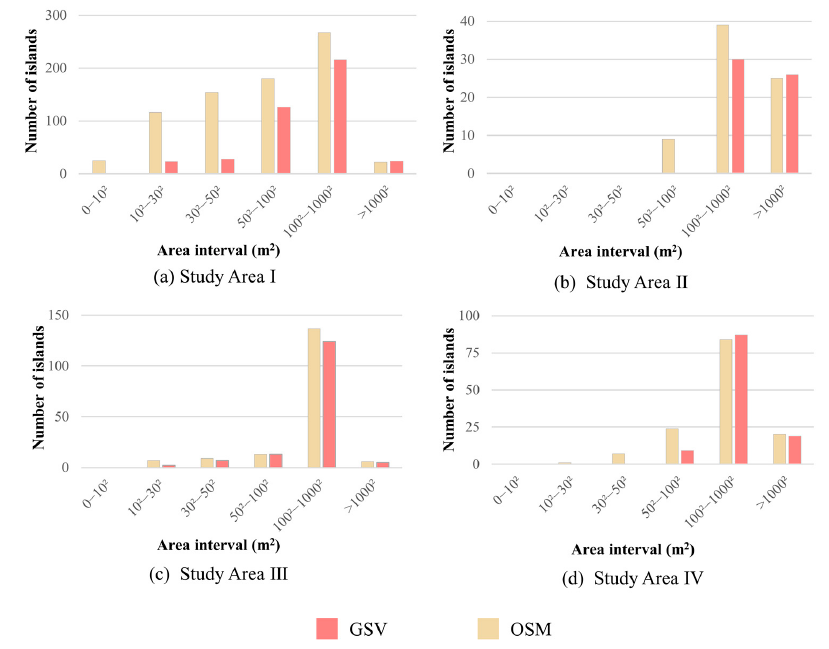
Figure 7. The number of islands (x-axis) in the two datasets (GSV and OSM) and for four study areas, considering different area intervals of islands (y-axis).